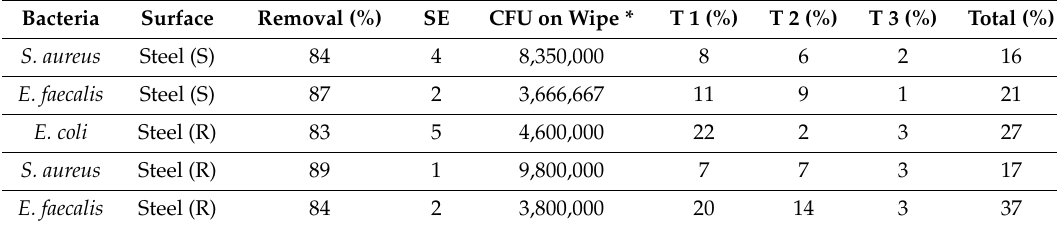
Table 5. Removal of bacteria and recontamination of surfaces by a 100% polypropylene nonwoven wipe. Steel (R) denotes rough steel samples. Steel (S) denotes smooth steel samples. * Average number of colony-forming units on the nonwoven fabric following wiping, calculated as the di ff erence between bacteria remaining on the surface before and after wiping [9]. T1, T2 and T3 represent the three consecutive transfers of bacteria. SE indicates the standard error of the